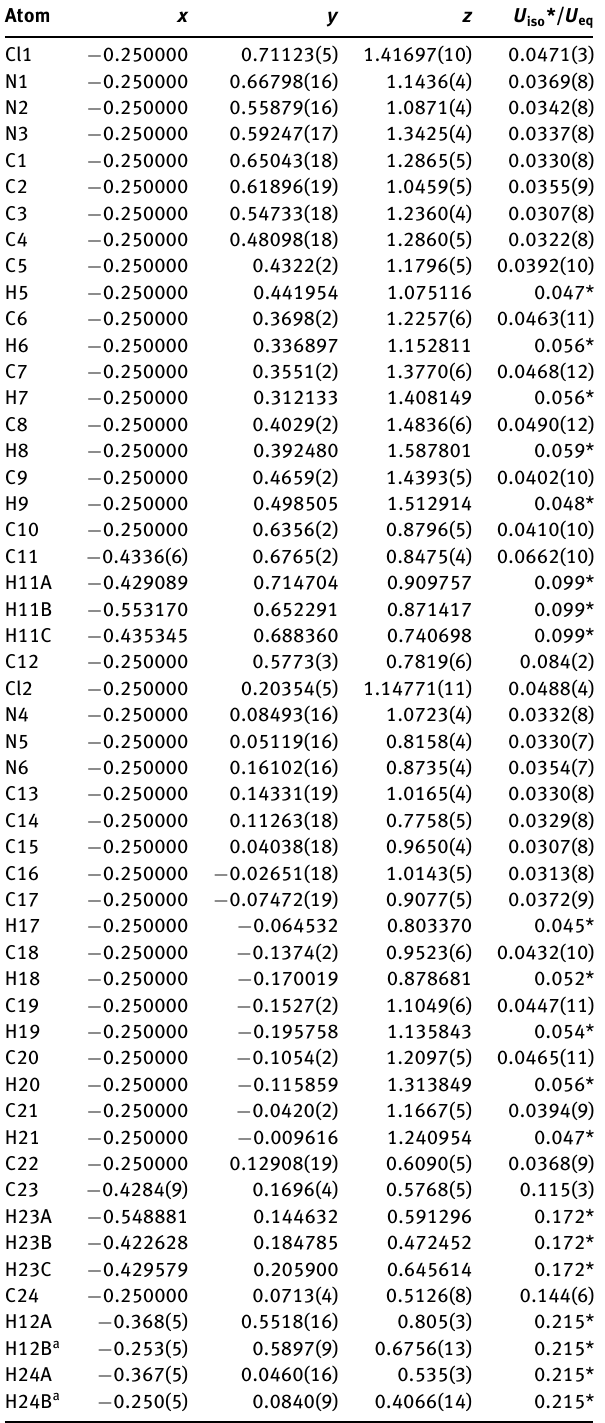
Table 2: Fractional atomic coordinates and isotropic or equivalent isotropic displacement parameters (Å 2